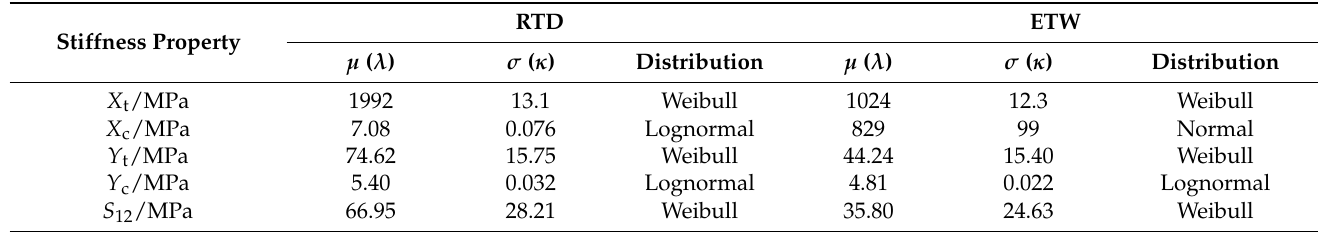
Table 12. Comparison of the probability distributions of the strength properties of